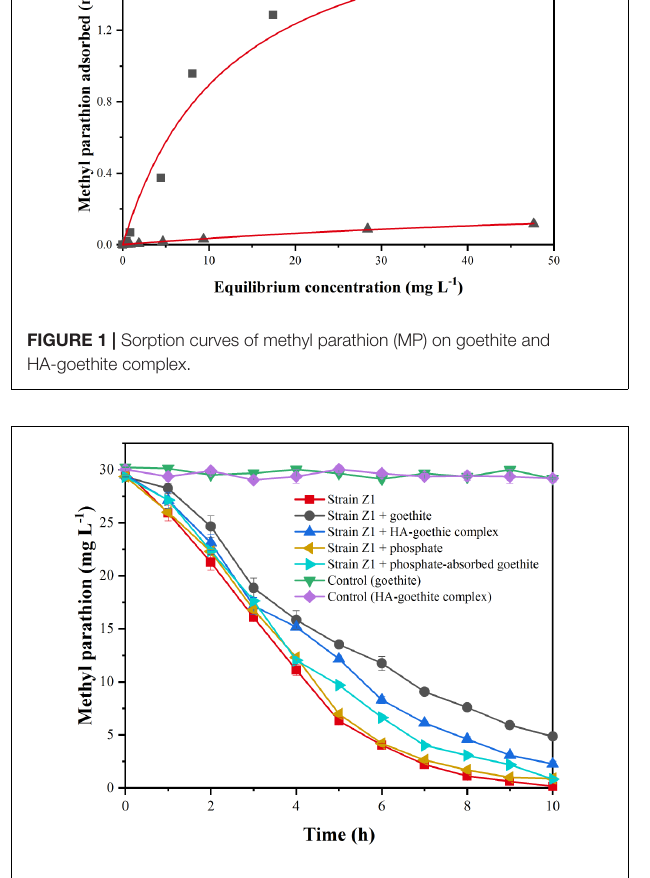
FIGURE 2 | Effect of minerals on biodegradation of MP by Pseudomonas sp. Z1.